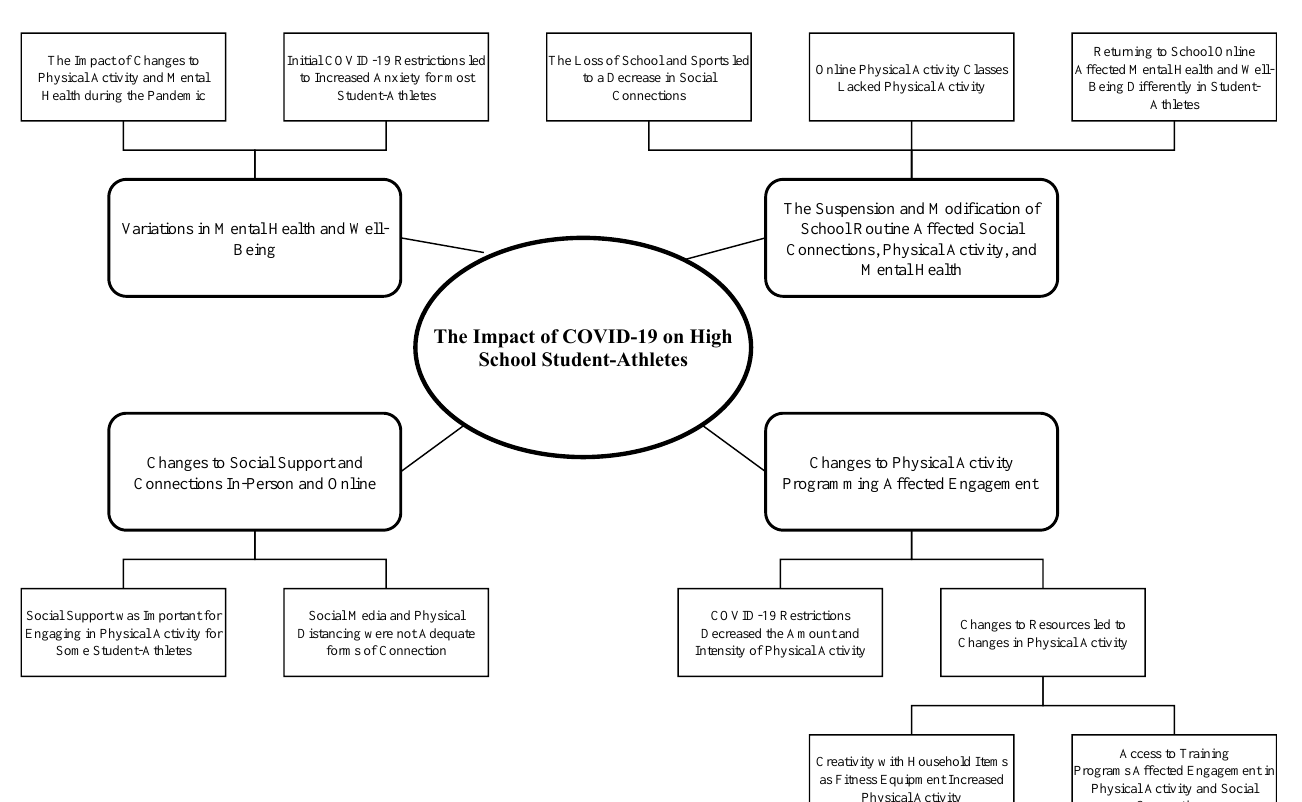
Figure 2. The impact of the COVID-19 pandemic on high school athlete’s experiences with physical activity, social connections, and mental health.